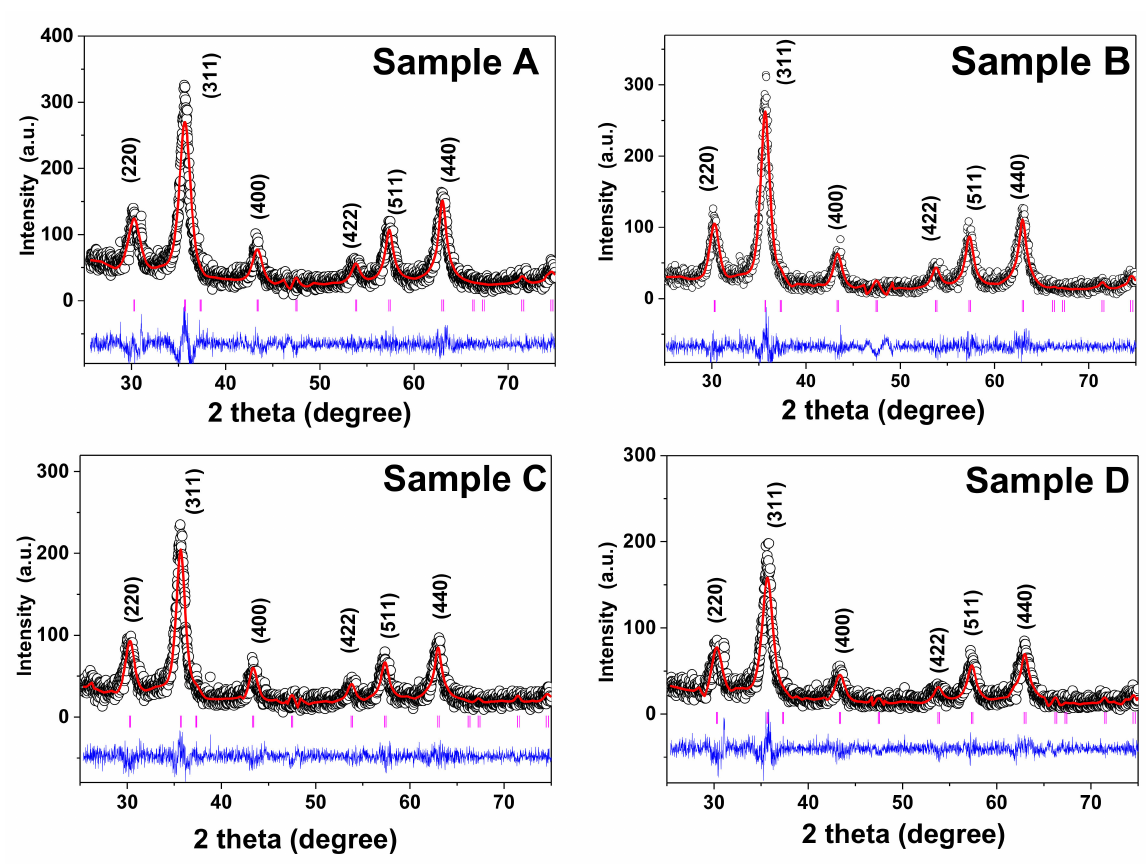
Figure 5. Rietveld refined XRD patterns of the AMF samples ( A – D ). The open circles show the experimental data and the solid lines show the refined XRD patterns. The blue line at the bottom shows the difference between the observed and calculated patterns and the vertical standing lines shows different Braggs’